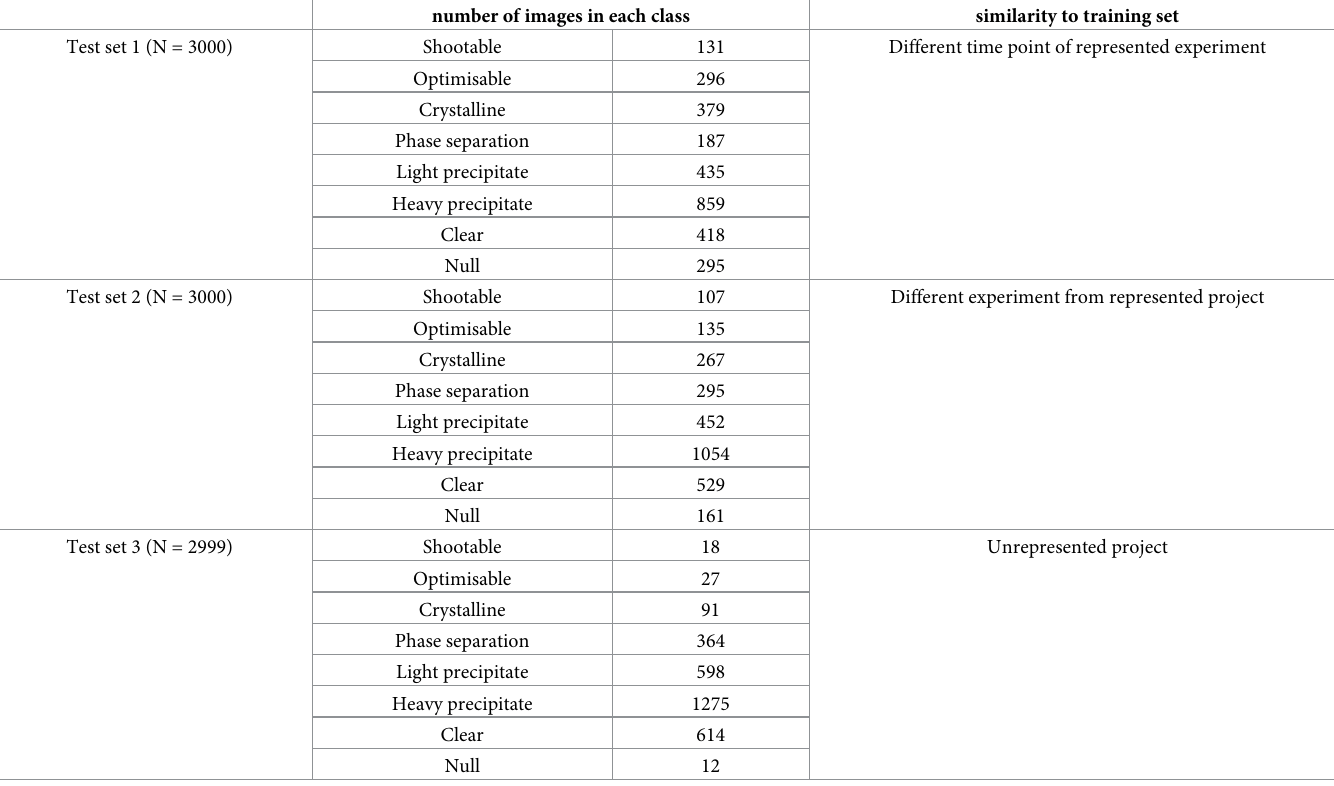
Table 2. Test data sets. The number of images in each class for the three different test sets with their similarity to images in the training